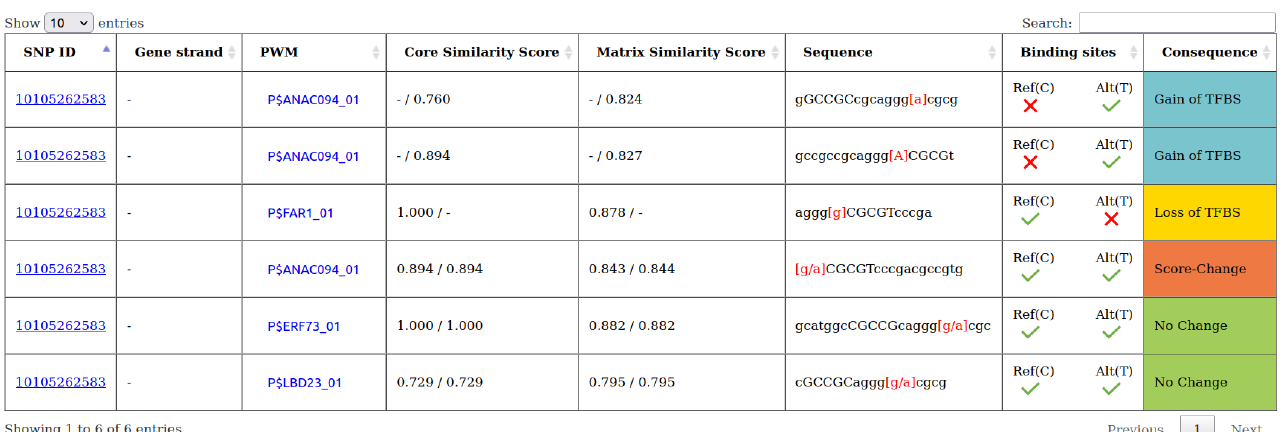
Figure 1. Example of a search result from agReg-SNPdb-Plants showing table TFBS_results . The search was performed with the SNP ID 10105262583 from Asian rice (Japonica Group).